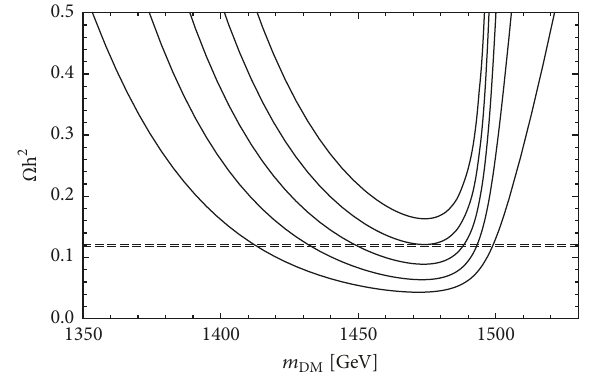
Figure 2: The relic abundance of the 𝑍 耠 퐵−퐿 portal right-hard neutrino dark matter as a function of the dark matter mass ( 𝑚 ) DM for 𝑚 푍 󸀠 = 3 TeV and various values of the gauge coupling 𝛼 = 0.001, 0.0014, 0.002, 0.003 , and 0.005 (solid lines from top to 퐵−퐿 bottom). The two horizontal lines denote the range of the observed ℎ 2 ≤ 0.1213 dark matter relic density, 0.1183 ≤ Ω DM